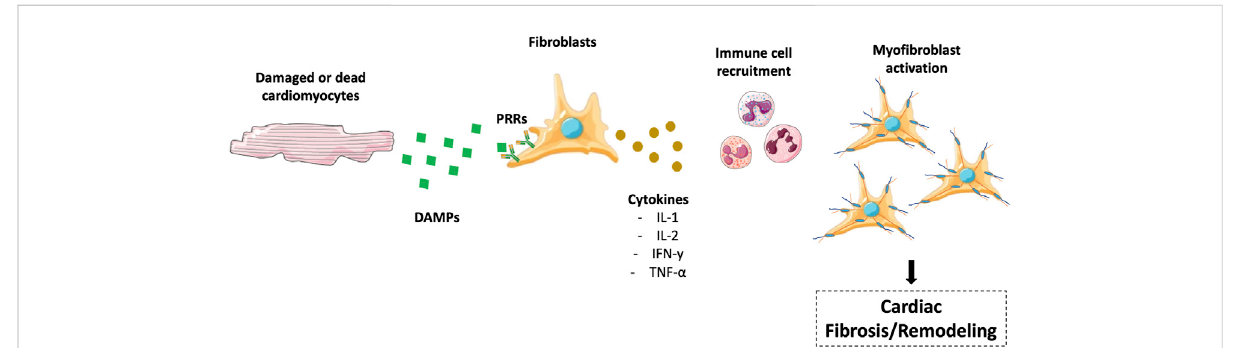
FIGURE 1 Regulation of in fl ammation in cardiac remodeling/ fi brosis. Damaged or dead cardiomyocytes secrete DAMPs, which interact with PRRs to produce cytokines, including IL-l, IL-2, IFN-y, and TNF- α . These molecules promote immune cell recruitment in the heart, translating in myo fi broblastactivationandcardiac fi brosis.The fi gurewaspartlygeneratedusingServierMedicalArttemplates,whicharelicensedunderaCreative Commons Attribution 3.0 Unported License; https://smart.servier.com.